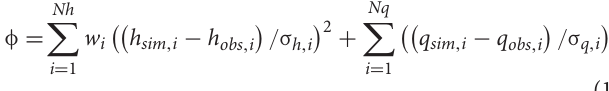
TABLE 1 | Parameters used in the SNESIM simulations. Parameters are only defined when they deviate from the default values. Cmin = 100 Max. conditioning = 100 Number of multigrids = 8 Subgrids = 1 Number of previously simulated nodes = 6